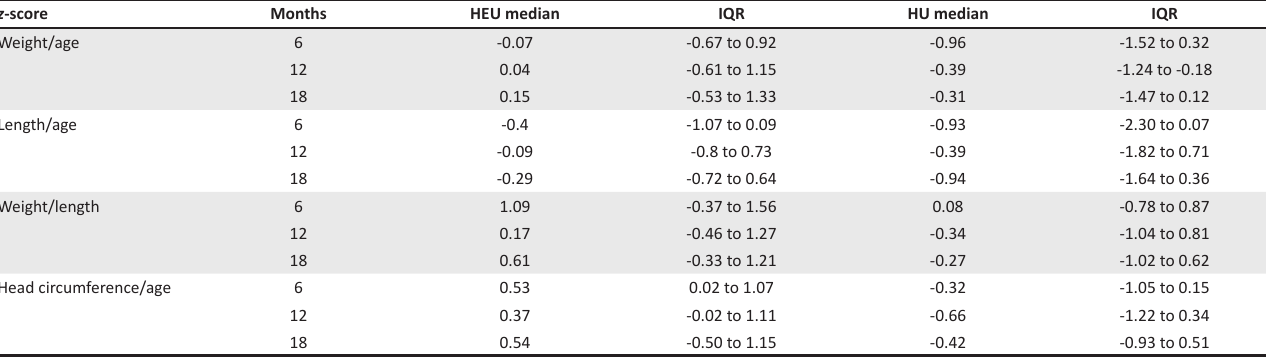
TABLE 3: Anthropometry of HIV-exposed uninfected and HIV-unexposed infants. z -score